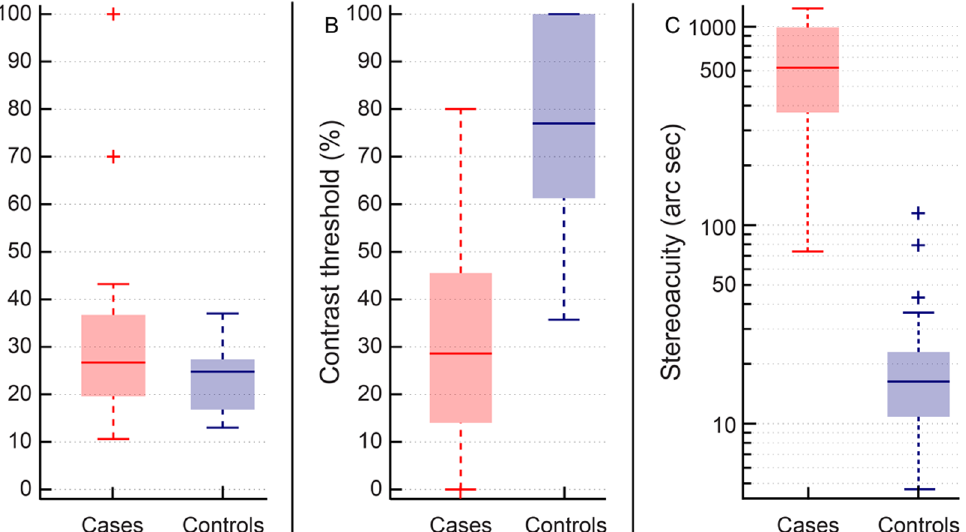
Fig 4. Binocular threshold (panel A), contrast threshold (panel B) and stereoacuity (panel C) of cases and controls that participated in this study. Details of Box and Whisker plot same as Fig 1.